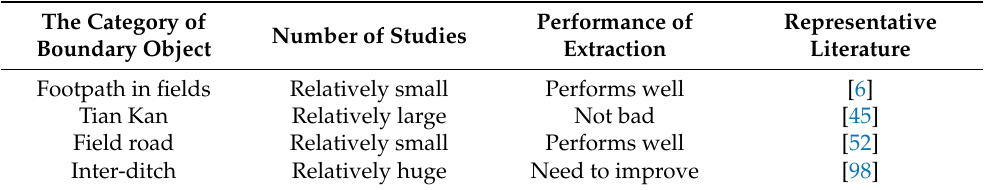
Table 9. Categories, numbers, performances, and the representative literature of boundary object extraction